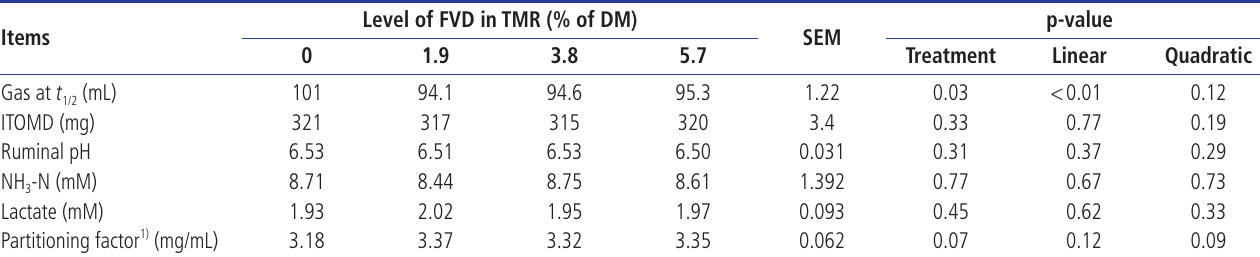
Table 4. Gas production and ruminal metabolites of diets with different levels of FVD Items